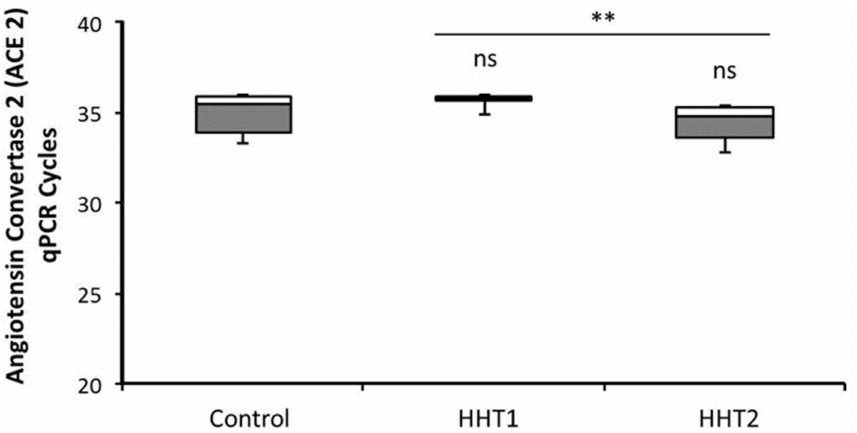
Figure 1. RT-qPCR of Angiotensin Convertase Enzyme type 2 in macrophages of HHT1, HHT2 and Control donors. Mononuclear cells from healthy and HHT donors were cultivated in DMEM with 10% FCS, and treated by LPS 10 ng/mL for 48 h. Cells were lysed, and RNA was extracted as described in Materials and Methods. RT-qPCR was performed for ACE2 receptor in 4 HHT2, 3 HHT1 and 4 control donor samples. Figure represents the number of cycles corresponding to the Ct of the amplification curve at similar Actin RNA amount taken as housekeeping gene. Ns—not significant; ** p <